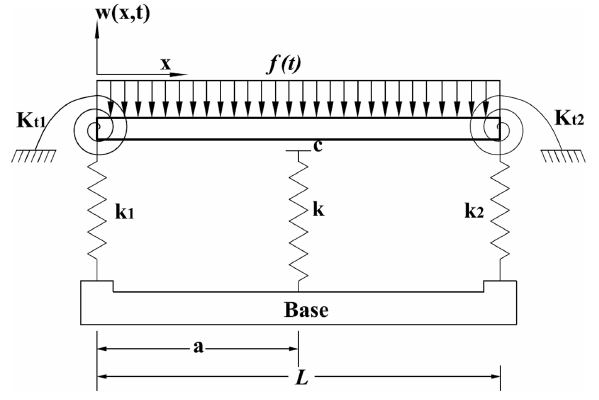
Fig. 1. Beam model with adjustable boundary conditions and variable single-sided contact at location a with gap c